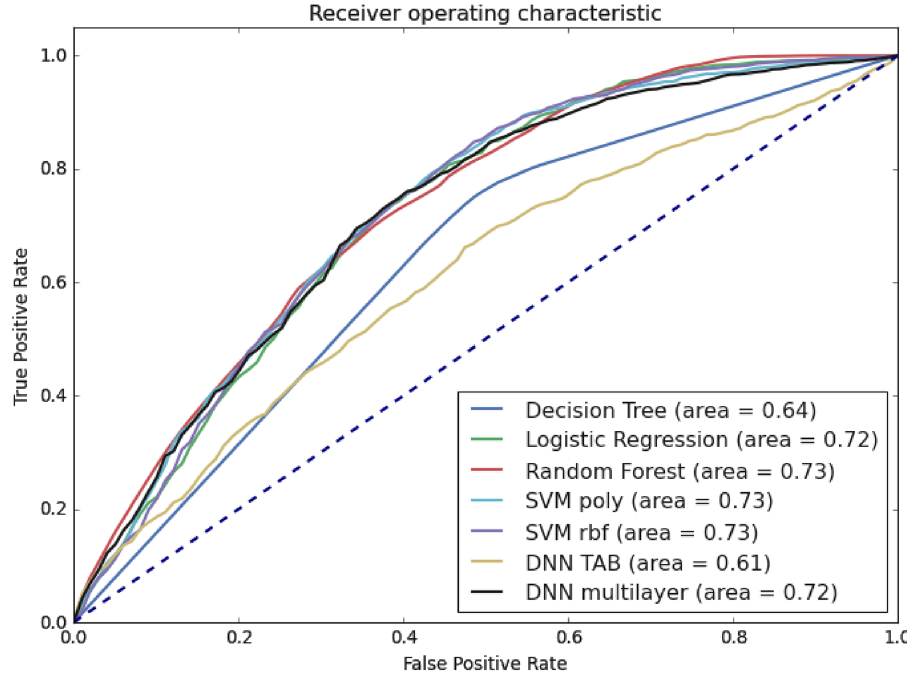
Figure 3. Receiver Operating Characteristic Curve (ROC curve) for all classification